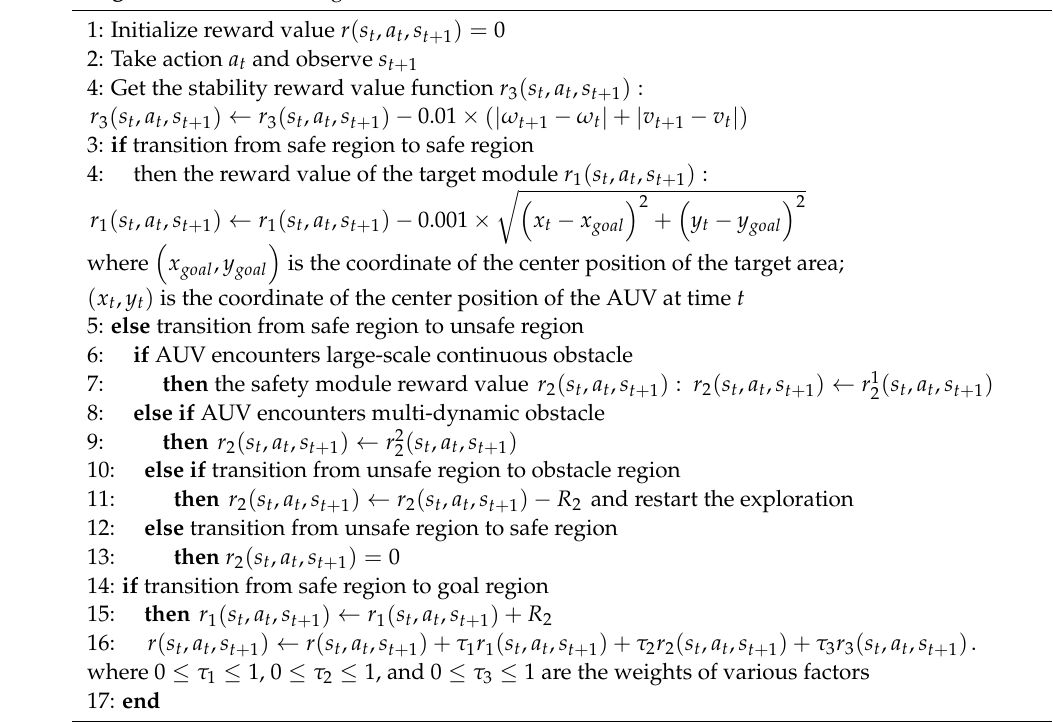
Algorithm 1. Reward Algorithm for AUV Obstacle